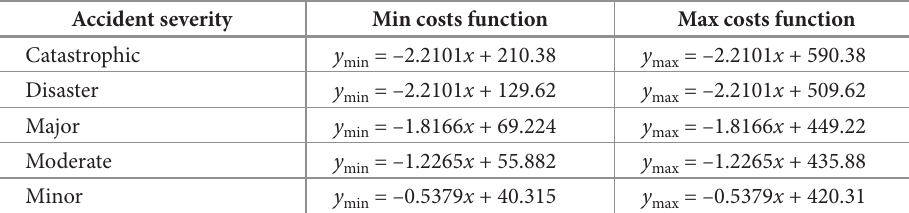
Table 11. Accident related costs as a function of accident severity and aircraft